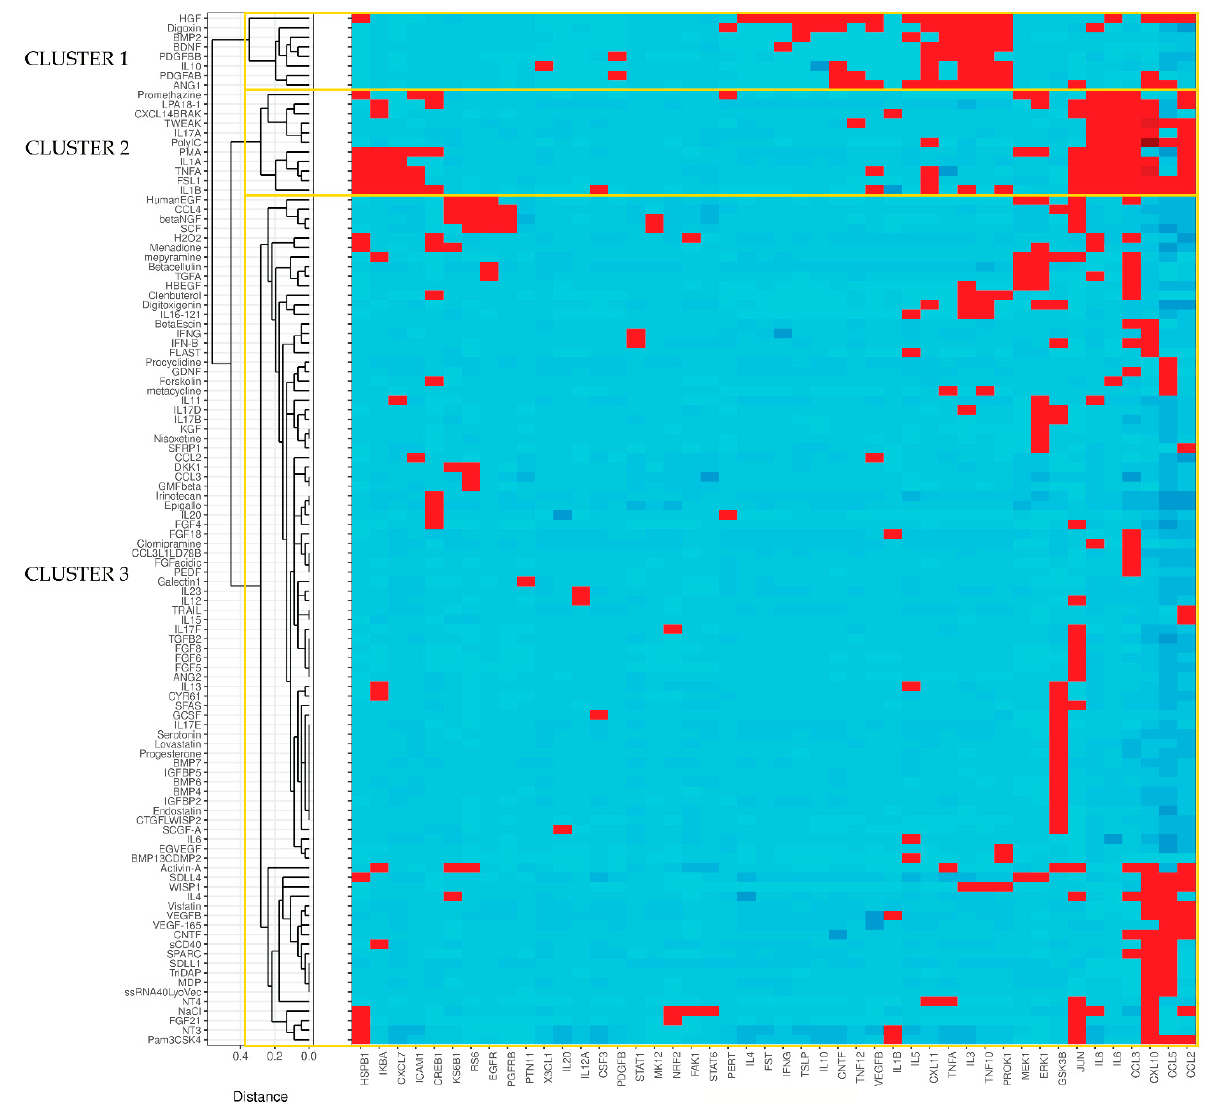
Figure 6. LPA clusters with proinflammatory stimuli. Heatmap of the active stimuli clustered in three major groups (1-3). Inactive stimuli and globally unresponsive signals were removed. Pairwise stimuli distance was calculated on binary transformed fold change values using Gower’s metric prior to divisive clustering. See also Figures